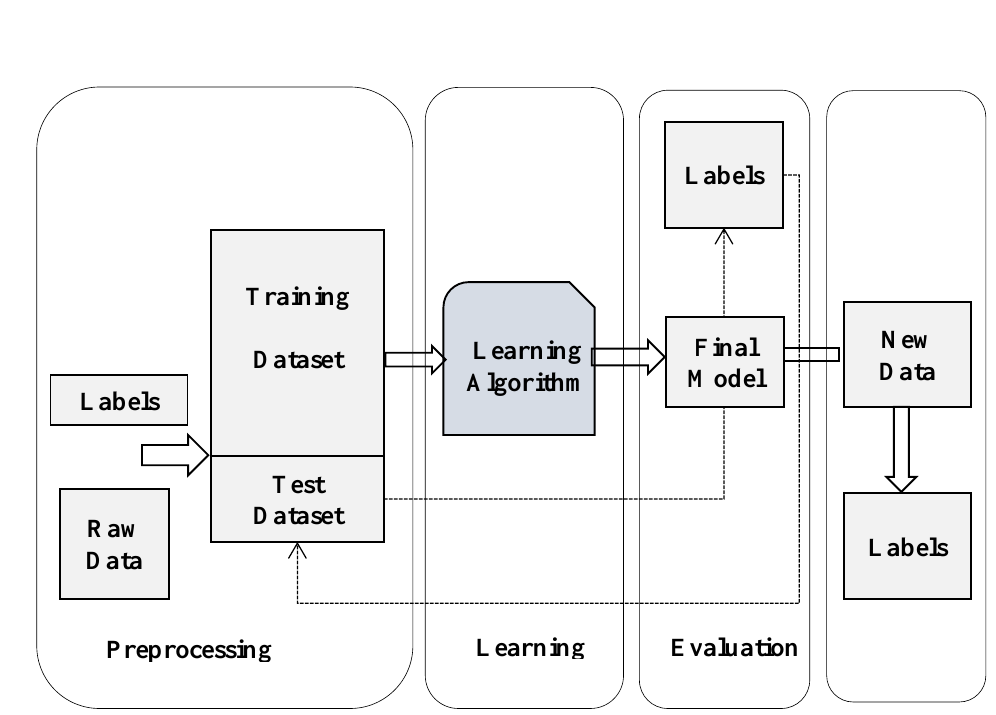
Figure 2. Machine learning logical